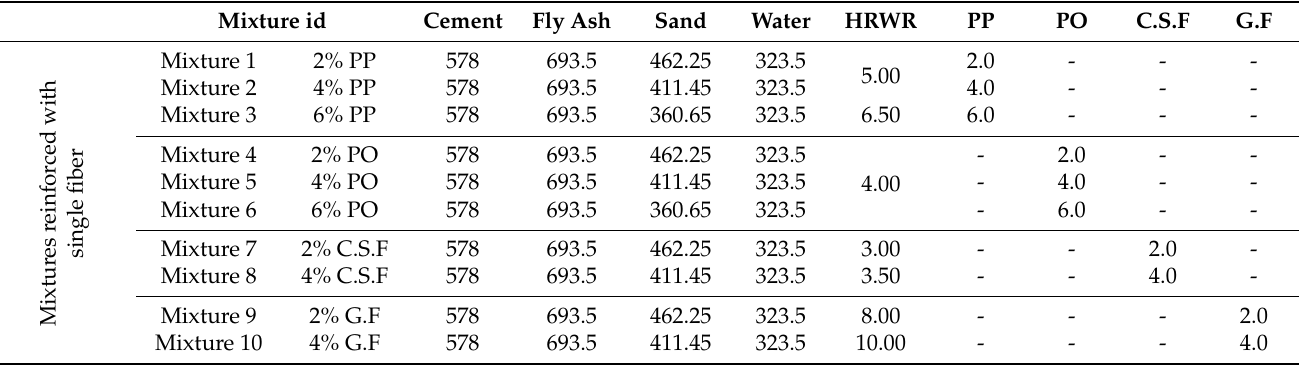
Table 3. Mix proportions in kg/m 3 for FRC and ECC